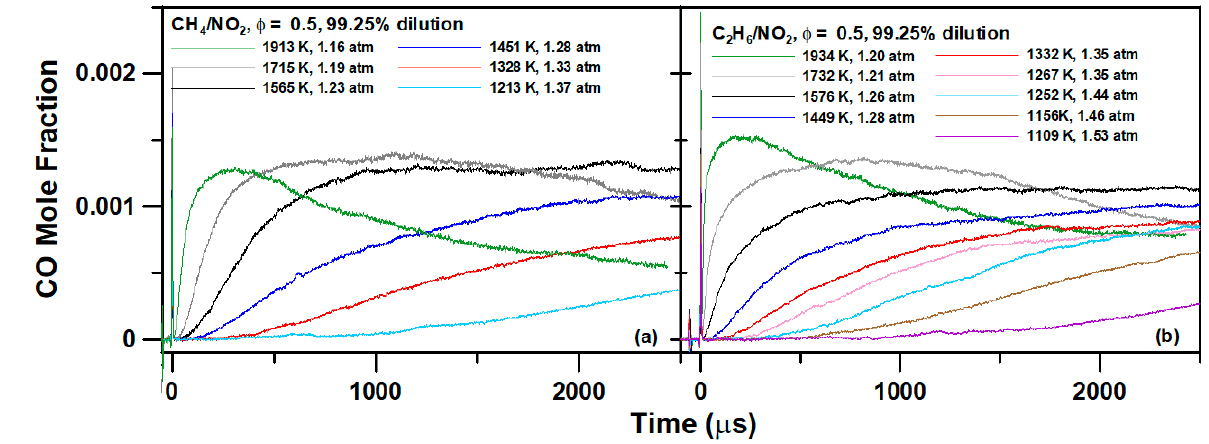
Figure 4. CO profiles for ( a ) methane and ( b ) ethane obtained during the course of this study.